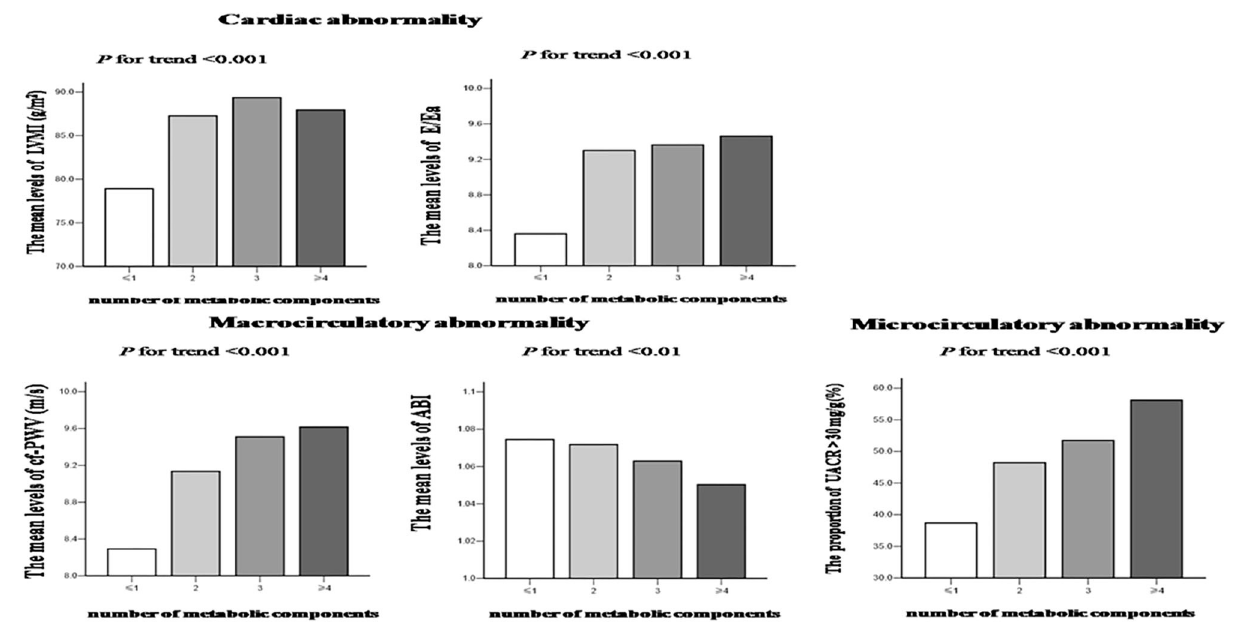
FIGURE 1 | Distributions of asymptomatic cardiovascular impairments according to the number of metabolic syndrome components. A UACR > 30 mg/g was used as the cutoff point for trend analysis because UACR had a skewed distribution. Trends for the mean or frequency among the groups were estimated using the ANOVA test or a linear-by-linear